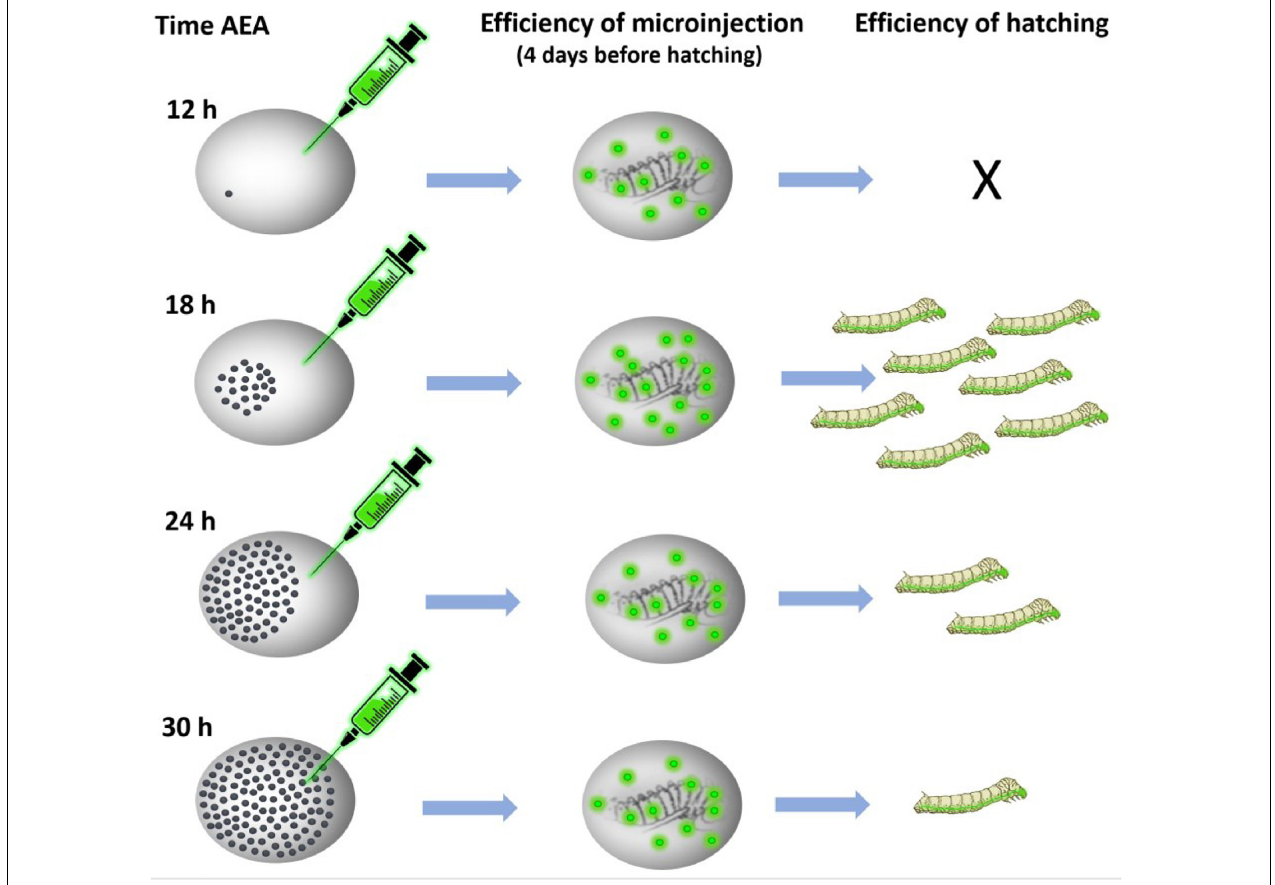
FIGURE 5 | Schematic representation of the procedure of transgene microinjection. Time AEA, time after egg